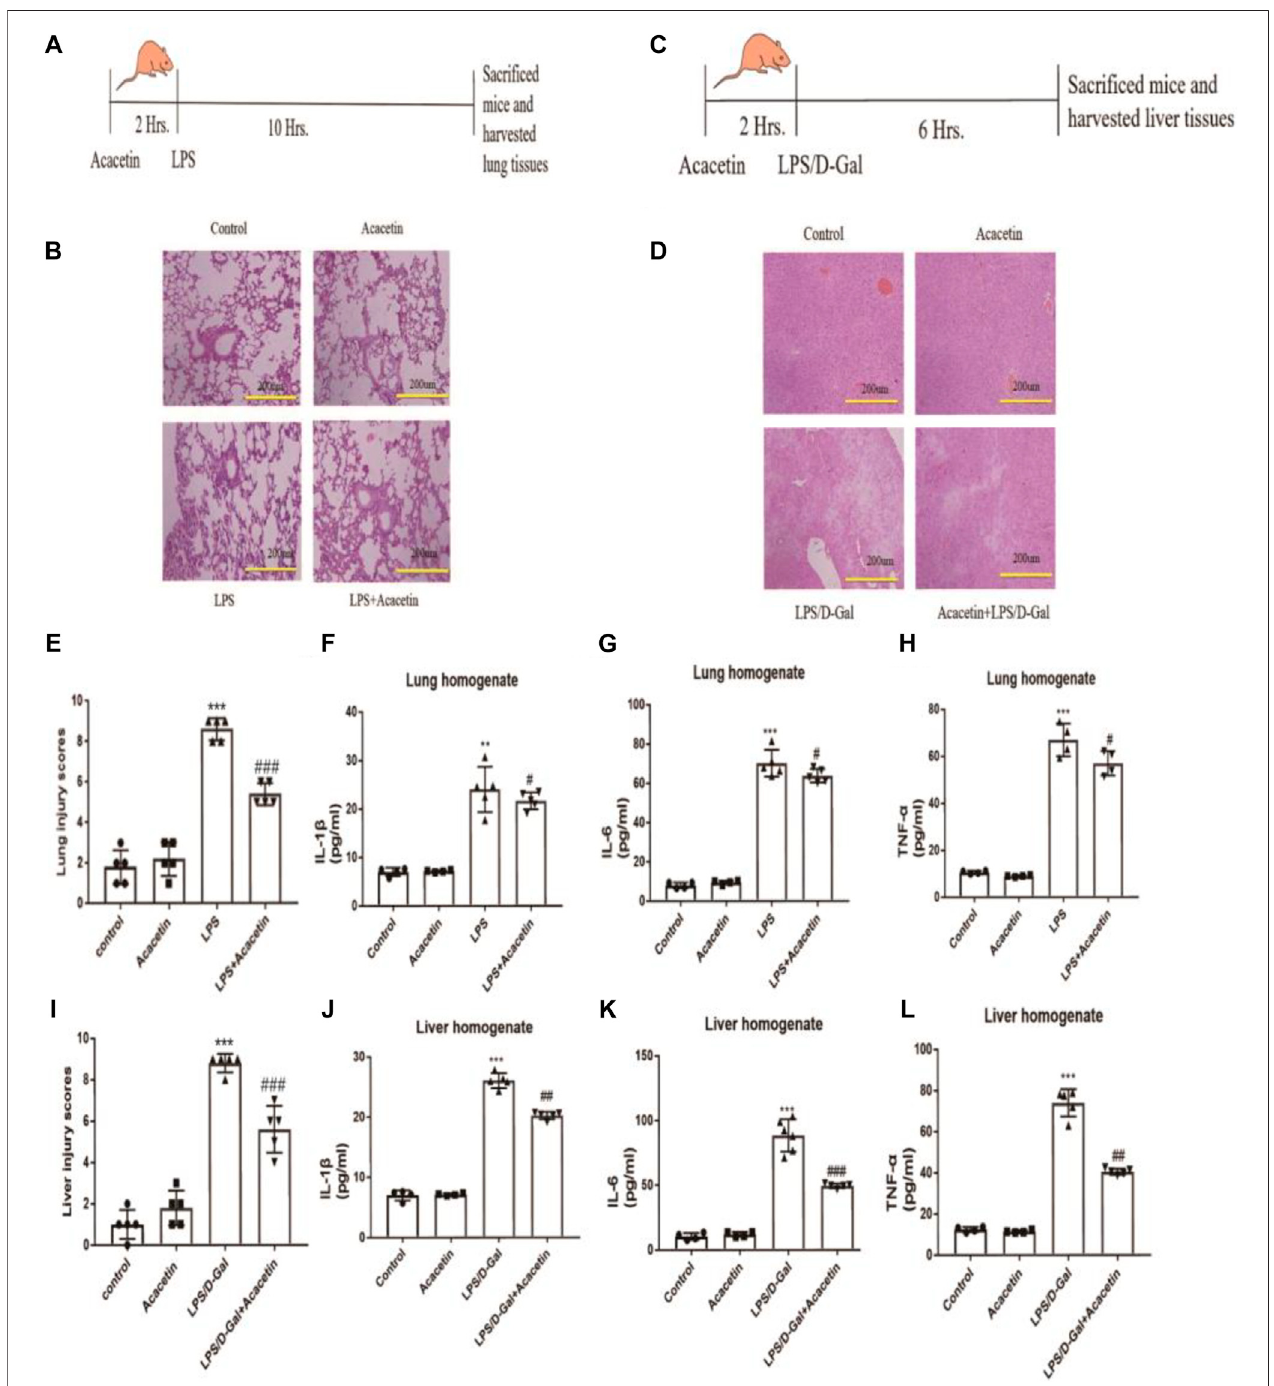
FIGURE 1 | The protective effect of acacetin against sepsis in vivo . (A) and (C) Methods to generate two in fl ammatory models and diagram showing the drawing time. (B) and (D) Histopathological damagetothelung ( × 200)and liver ( × 200). (E) and (I) Lungand liver injuryscores. Thelung (F) and liver (J) homogenate levelsofIL- 1 β (G) , (K) IL-6 (H) ,and (L) TNF- α weredetermined byELISA.Thedataareexpressed asthemean ± SEM(n (cid:1) 5).* p < 0.05,** p < 0.01,*** p < 0.001,comparedwiththe control group; # p < 0.05, ## p < 0.01, ### p < 0.001, compared with the LPS-stimulated group.